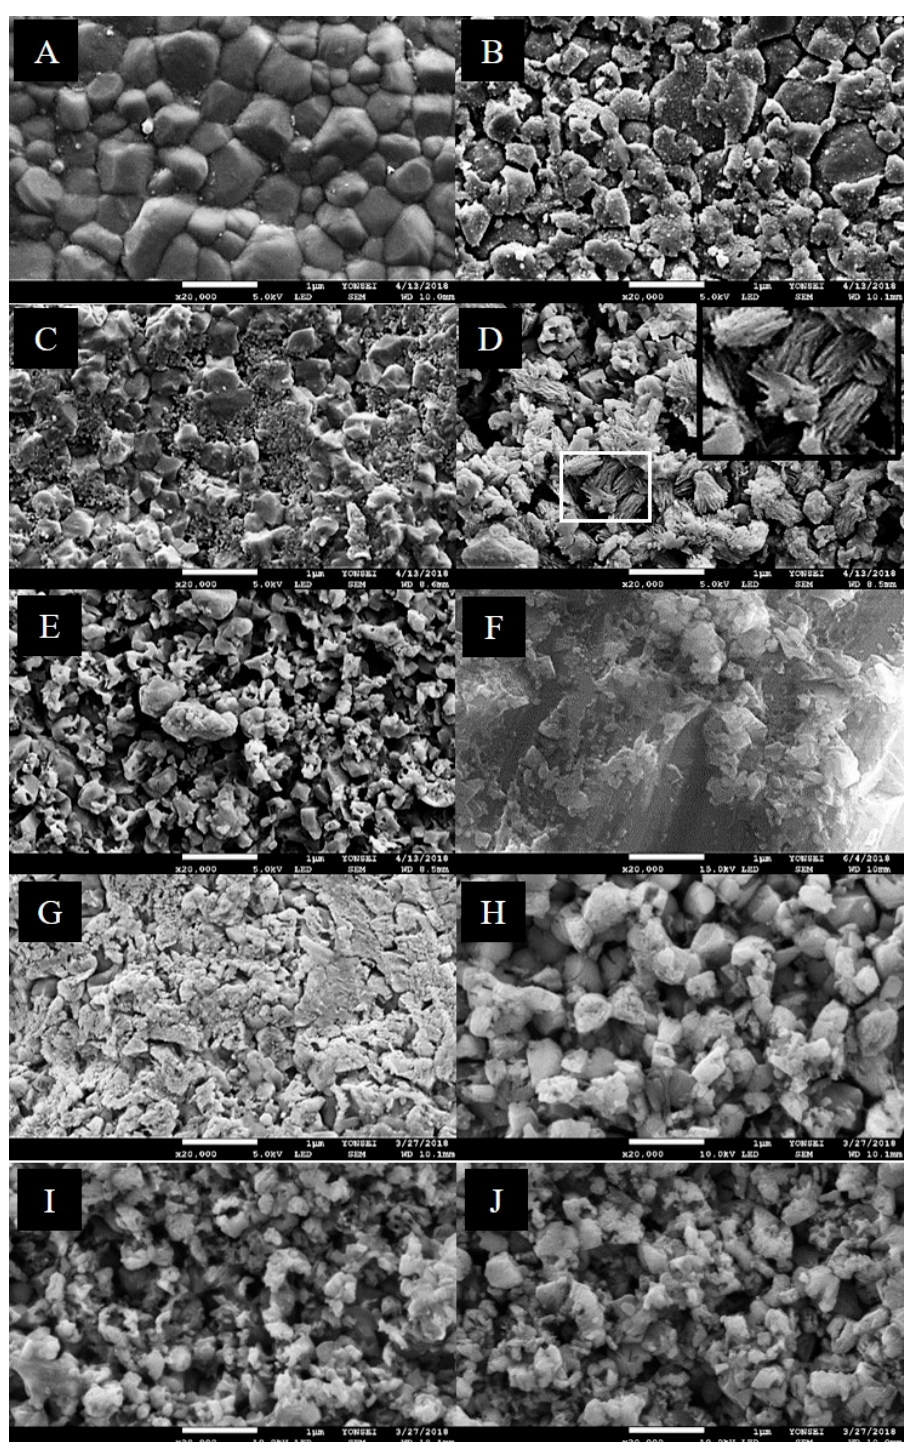
Figure 2. SEM micrographs (magnification 20,000×) of as-sintered and air-abraded zirconia specimens following etching for different time periods. As the etching time increased, the grain size decreased and became irregular overall. ( A ) As-sintered zirconia surface. ( B – E ) As-sintered zirconia surface subjected to etching for 1, 5, 15, and 30 min. ( F ) Air-abraded zirconia surface. ( G – J ) Air-abraded zirconia surface subjected to etching for 1, 5, 15, and 30 min. The surface of air-abraded zirconia was rougher and more irregular. ( D ) The domain structure due to the transformation intothe monoclinic zirconium dioxide (black square).